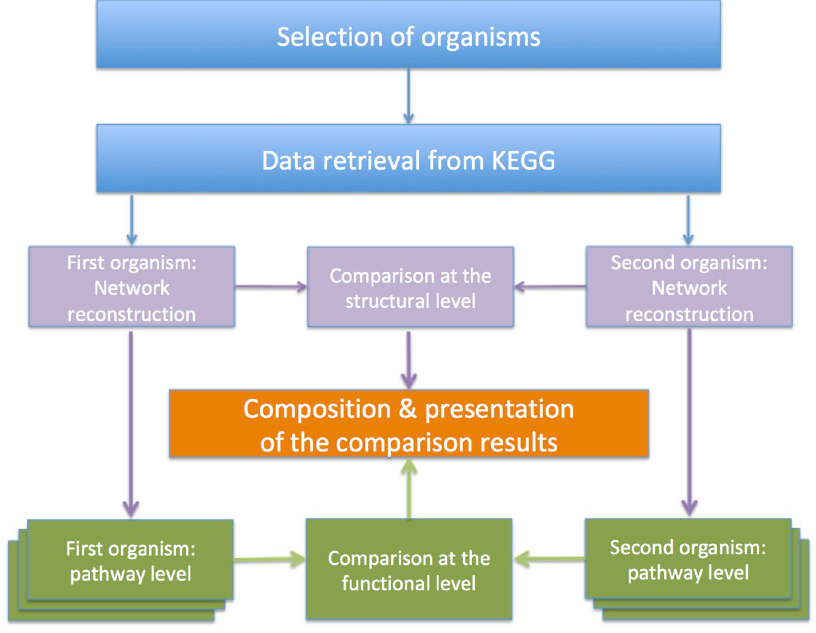
Fig 1. Pairwise metabolism comparison of different organisms: Overall view of the proposed